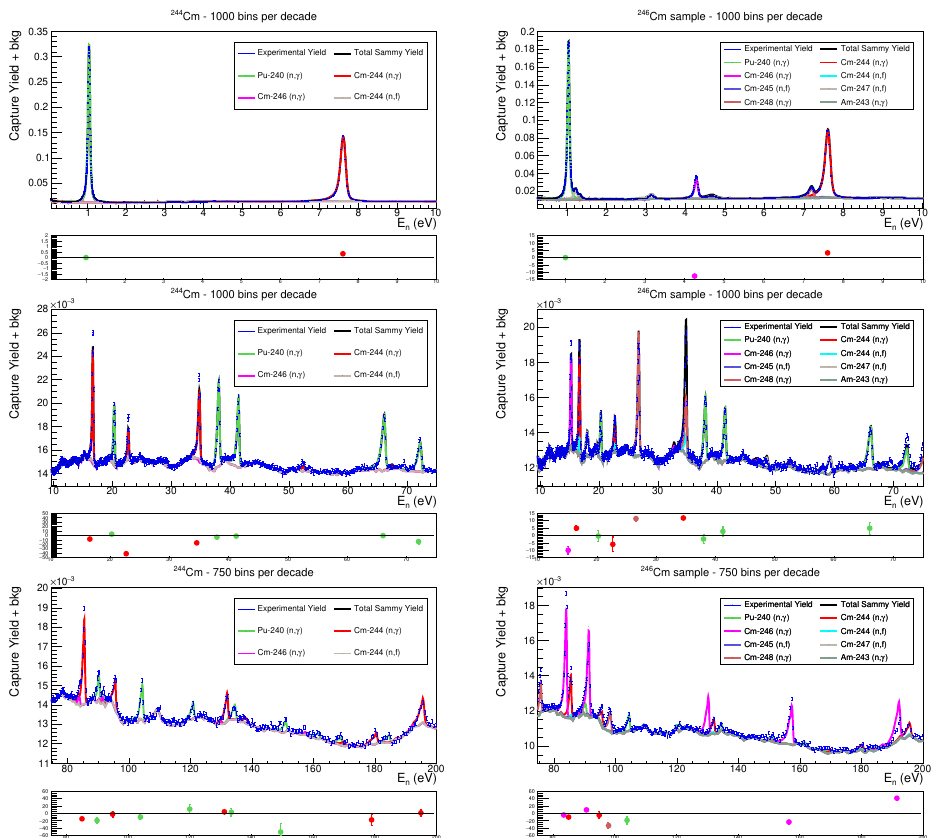
Figure 3. Preliminary experimental yields (no background subtracted) of the measured 244 Cm (left) and 246 Cm (right) samples. Together with the experimental data points, we show an estimation of the contribution of the capture and fission reactions in each isotope present in the samples. These contribu- tions have been obtained using the SAMMY computer code to calculate the reaction yields taking into account the experimental conditions such as Doppler and resolution broadening, and taking the reaction cross sections from JEFF-3.3. The resulting yields were then normalized to fit the experimental results and added to the background, obtained from dedicated